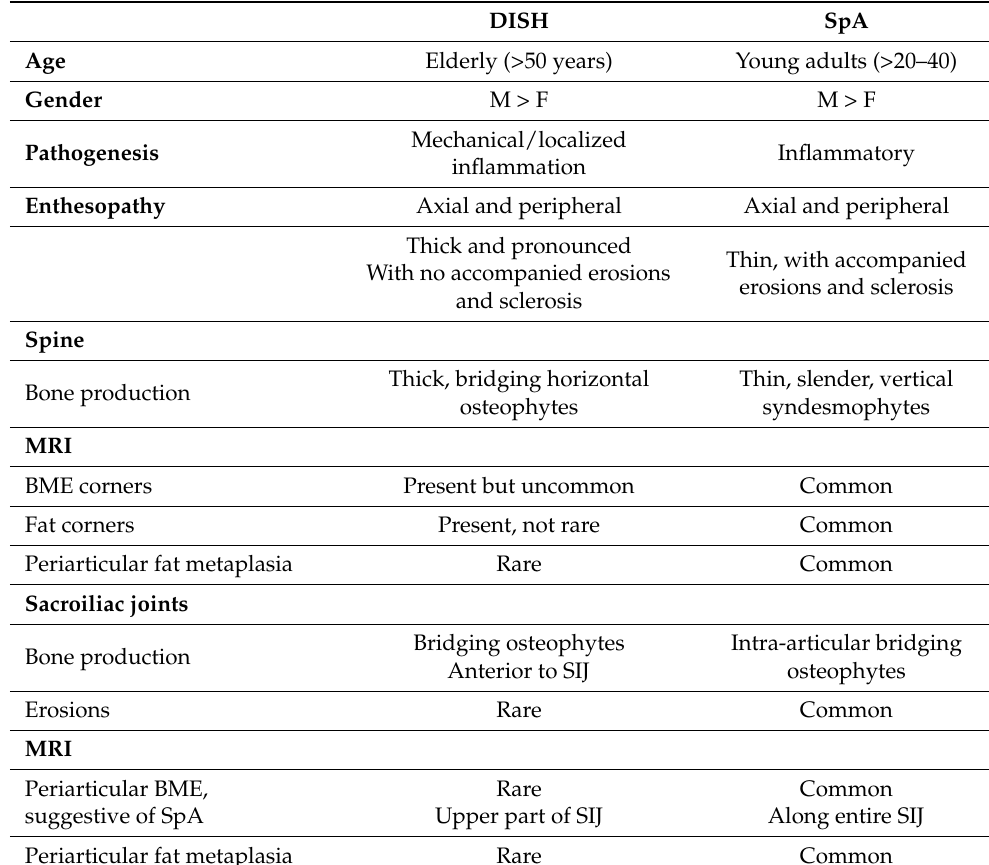
Table 1. DISH vs. Spondyloarthritis: differences and similarities .